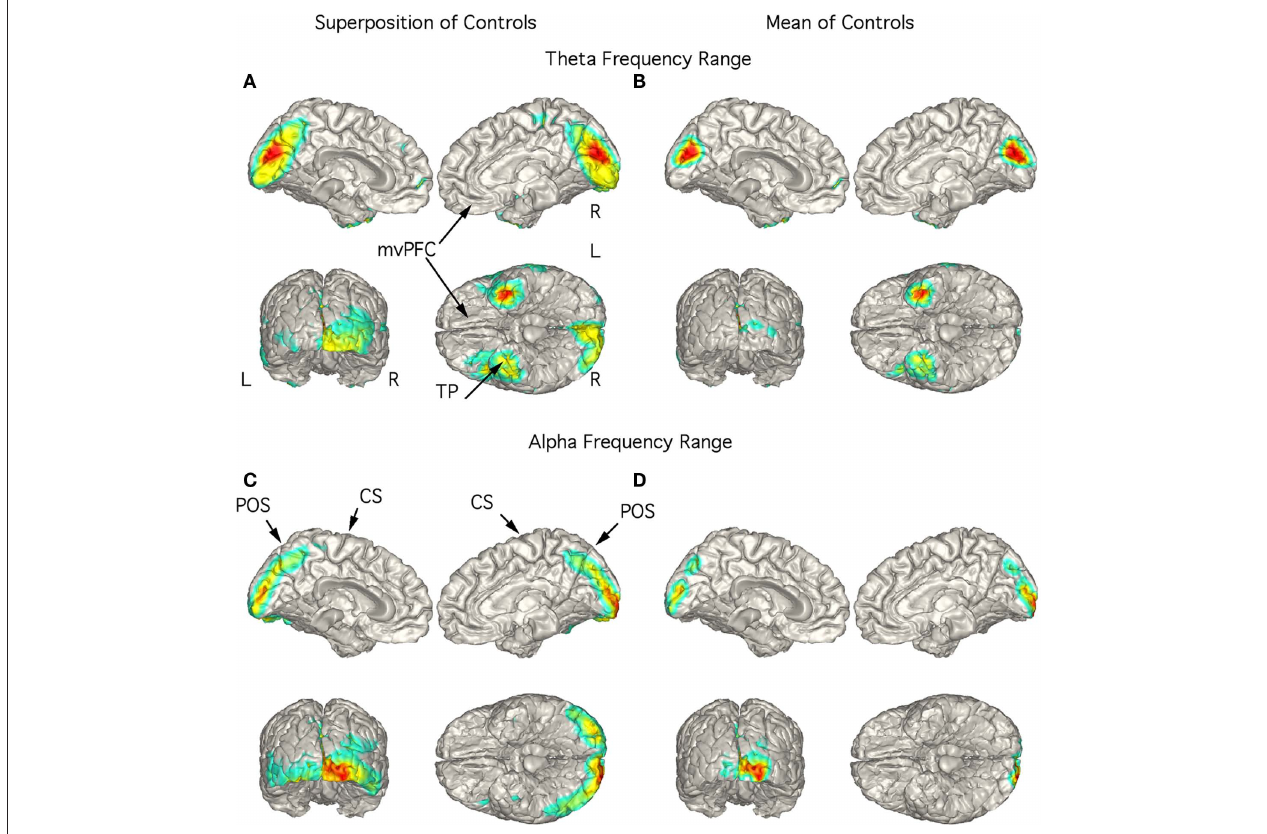
FiGure 2 | Localization of theta and alpha band current sources in controls. (A) Superposition of theta range independent components (ICs) seen in 8 of the 18 controls. Note that activity is to mesial occipital extending into the parietal cortex and left temporal pole (TP). (B) Mean of localizations shown in (A) . This